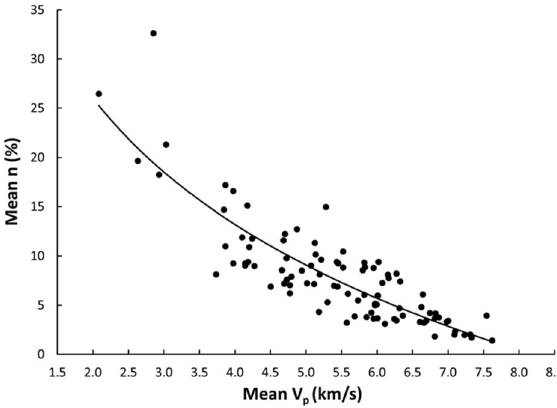
Figure 11. Relationship between the V p and n of limestone.